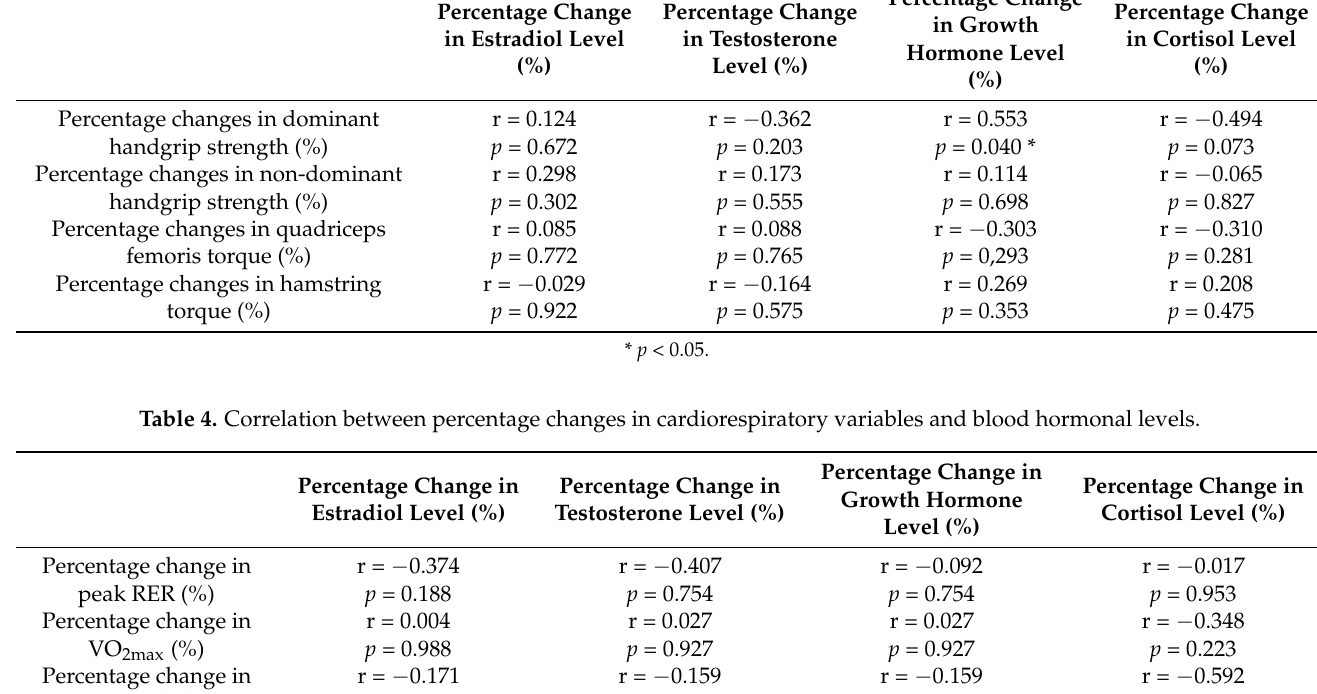
Table 3. Correlations between percentage changes in strength and hormonal levels. Percentage Change in Percentage Change in Percentage Change in Estradiol Level (%) Testosterone Level (%)